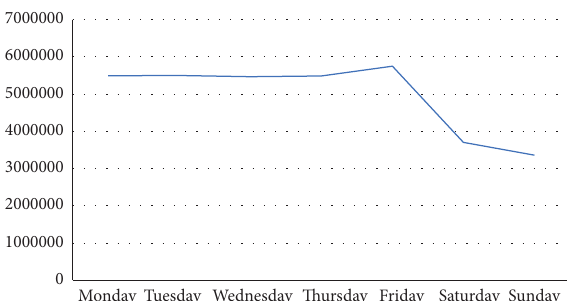
Figure 5: Daily network-wide trafc from April 16 to April 22,